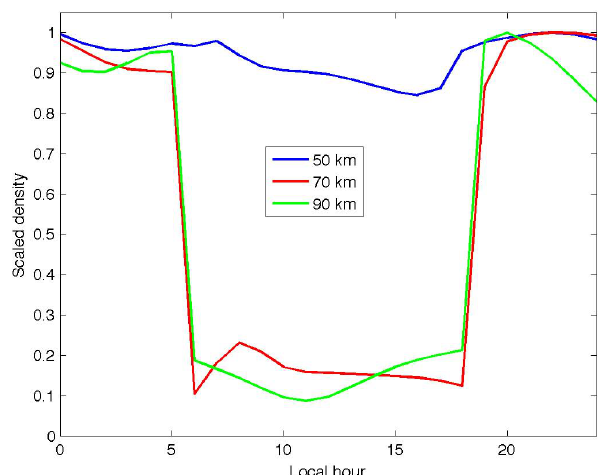
Fig. 6. Monthly ozone number density at 90km (upper panel, scaled by 10 8 cm − 3 ) and 20km (lower panel, scaled by 10 12 cm − 3 ) as a function of time and latitude in 1 August 2002–31 December 2008.